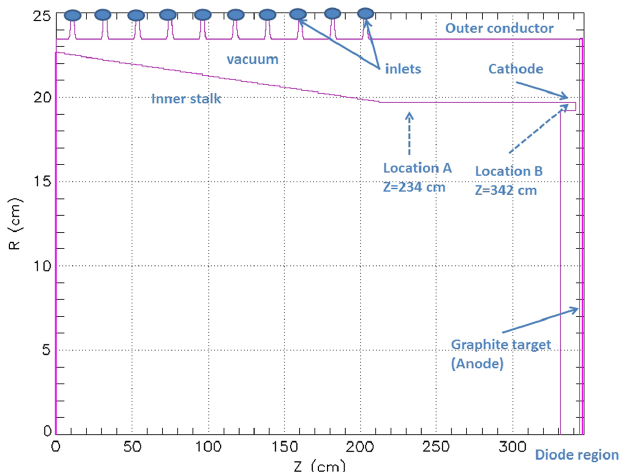
FIG. 3. Geometry used for simulating the 1 MV LTD coupled to the large area